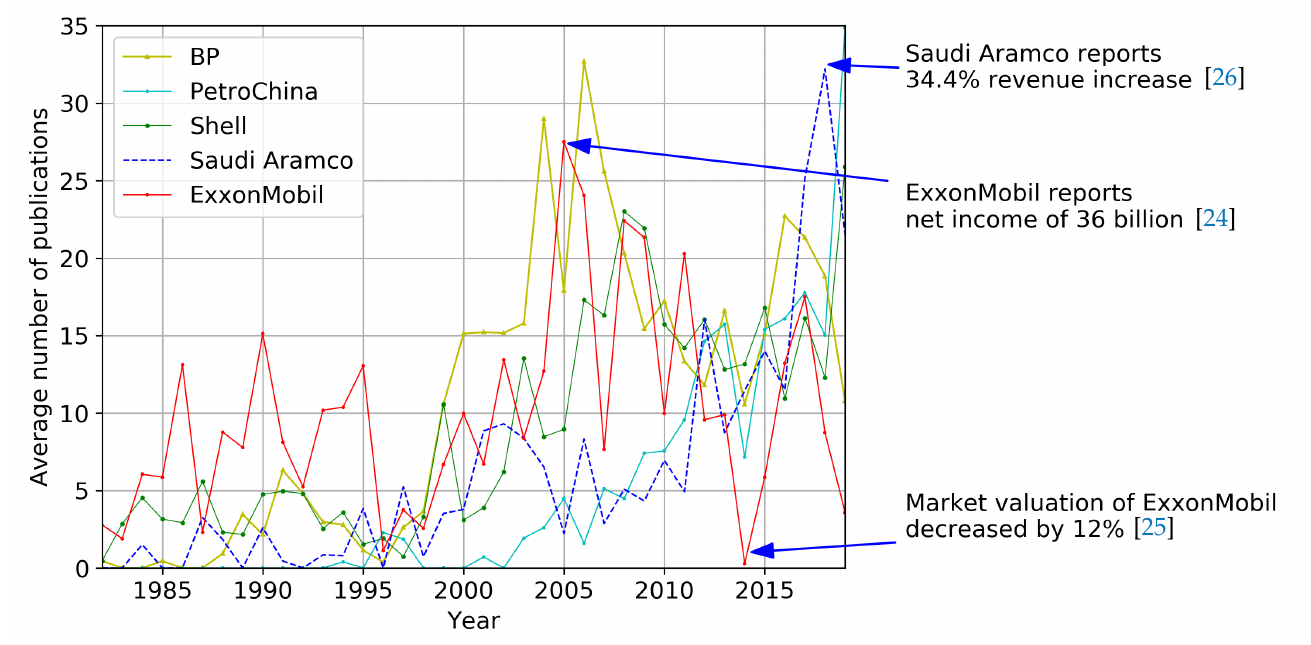
Figure 9. The average number of publications by oil and gas production companies